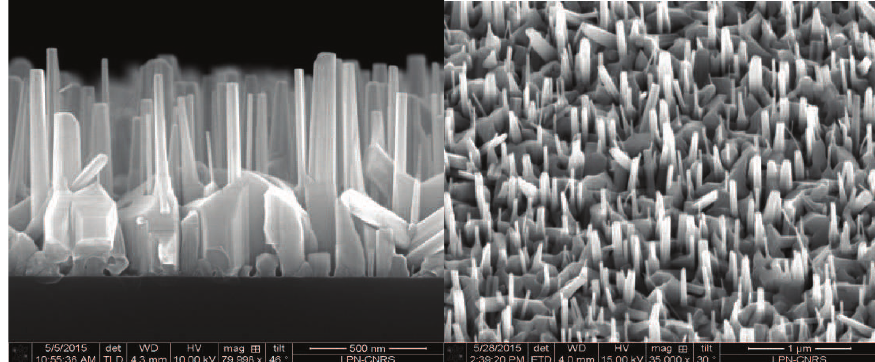
Figure 2. Scanning electronic microscope picture of GaN NWs on n-doped Si (111) substrate before the encapsulation into a polymer matrix. The NWs are growth at lower temperature than for sample (Figure 1), then leading to a smaller density and the appearance of a parasitic and thick-2D GaN layer located at the NW bottom here. The filling factor is less than 10%.